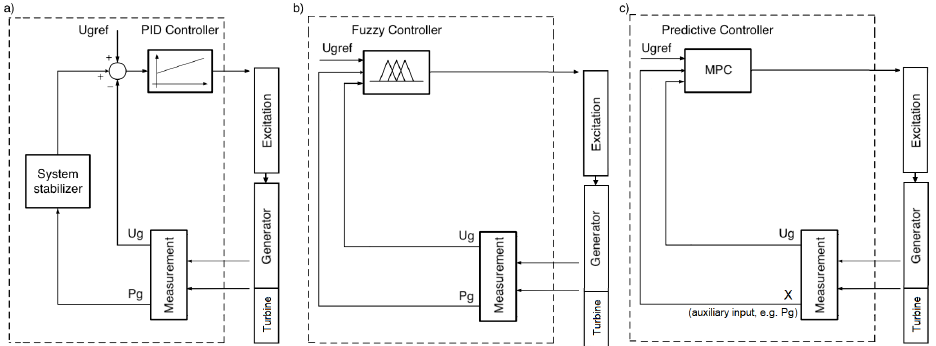
Figure 4. Standard synchronous generator control structure [14]. Considered parts of the system marked in gray (the controller and the power system stabilizer).